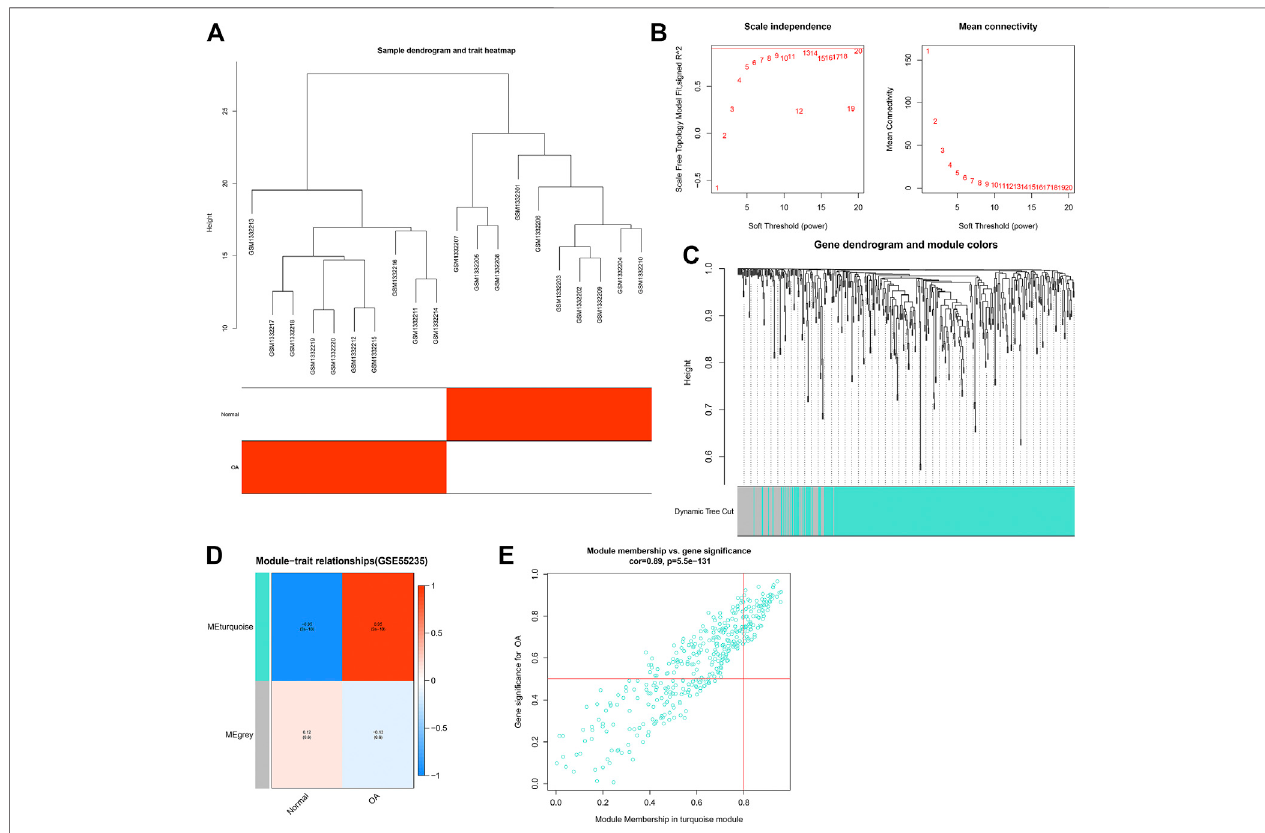
FIGURE2| Establishmentofco-expressionmodulesforOAintheGSE55235dataset. (A) Heatmapforsampledendrogramandclinicaltraits. (B) Determinationof soft-thresholding power ( β ). Under different β values, scale independence and mean connectivity were determined. (C) Gene dynamic cutting cluster tree. Each color representsamodule. (D) Heatmap forcorrelationsofmodules withclinicaltraits.Each rowrepresentsamodule, andeach columnrepresentsatrait.Thenumbersinthe rectangularboxrepresent thecorrelationcoef fi cientbetweenthemoduleandthetraitandthecorresponding p value.Redrepresentspositivecorrelation,andblue represents negative correlation. The darker the color, the stronger the correlation. (E) Scatter plots for the correlation between GS and MM in the turquoize module.